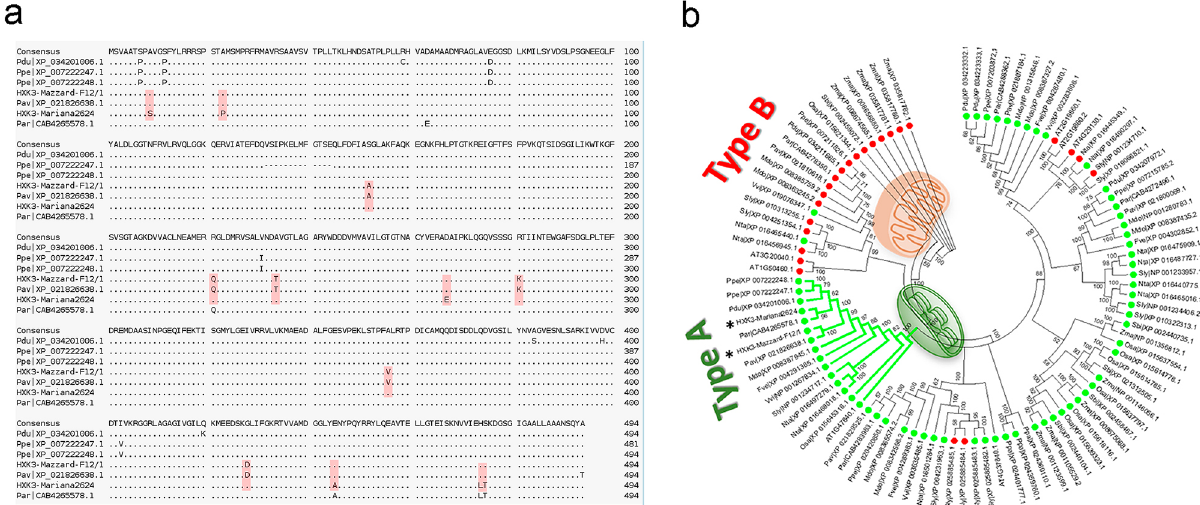
Figure 2. Identification of two putative Prunus HXK3 enzymes. ( a ) Comparison of predicted amino acid sequences of ‘M.2624’ HXK3 and ‘M.F12/1’ HXK3 with homologs from Prunus species. Differences at the amino acids level between proteins are enclosed in red squares. ( b ) Phylogenetic relationship among HXK proteins. The phylogram was generated with the MEGA 6.0 program from the multiple alignments of the deduced amino acid sequences from Prunus HXK3 and other angiosperm HXK proteins. Bootstrap values from 1000 replicates were used to assess the robustness of the tree. Green (chloroplast/plastid) and red (mitochondria) dots indicate the putative subcellular localization of HXK proteins (Plant-mSubP, http:// bioin fo. usu. edu/ Plant- mSubP/). The types of plant HXK are indicated. The positions of ‘M.2624’ and ‘F.12/1’ HXKs are indicated by asterisks. Gene identification are: AT, Arabidopsis thalian a; Fve, Fragaria vesca subsp. vesca ; Mdo, Malus domestica ; Nta, Nicotiana tabacum ; Osa, Oryza sativa Japonica Group; Ppa, Physcomitrella patens ; Par, Prunus armeniaca ; Pav, Prunus avium ; Pdu, Prunus dulcis ; Ppe, Prunus persica ; Sly, Solanum lycopersicum ; Sbi, Sorghum bicolor ; Vvi, Vitis vinifera ; Zma, Zea mays